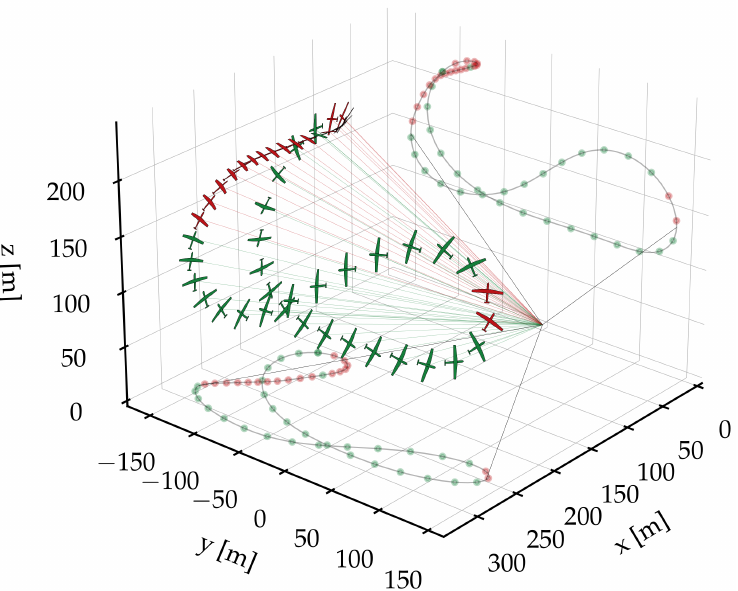
Figure 5. Locally optimal single-aircraft position and orientation trajectory nr. 3 (lemniscate pattern) as found by User A. For better visibility, the aircraft are depicted at a scale 5:1. Green color signifies positive power output, red color negative power